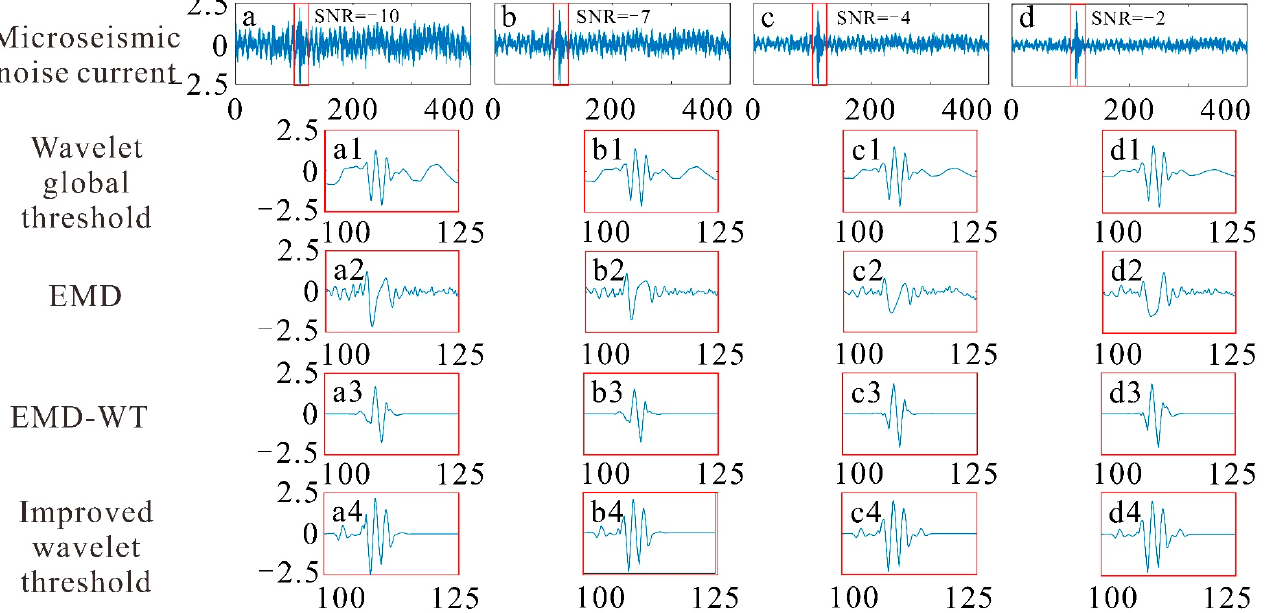
Figure 10. Comparison of the denoising of synthesized microseismic signals with noise, current and different SNRs: ( a ) microseismic noise current of SNR = − 10, ( b ) microseismic noise current of SNR = − 7, ( c ) microseismic noise current of SNR = − 4, ( d ) microseismic noise current of SNR = − 2, ( a1 , b1 , c1 , d1 ) Wavelet global threshold denoising signal, ( a2 , b2 , c2 , d2 ) EMD denoising signal, ( a3 , b3 , c3 , d3 ) EMD-WT denoising signal, ( a4 , b4 , c4 , d4 ) improved wavelet threshold denoising signal.